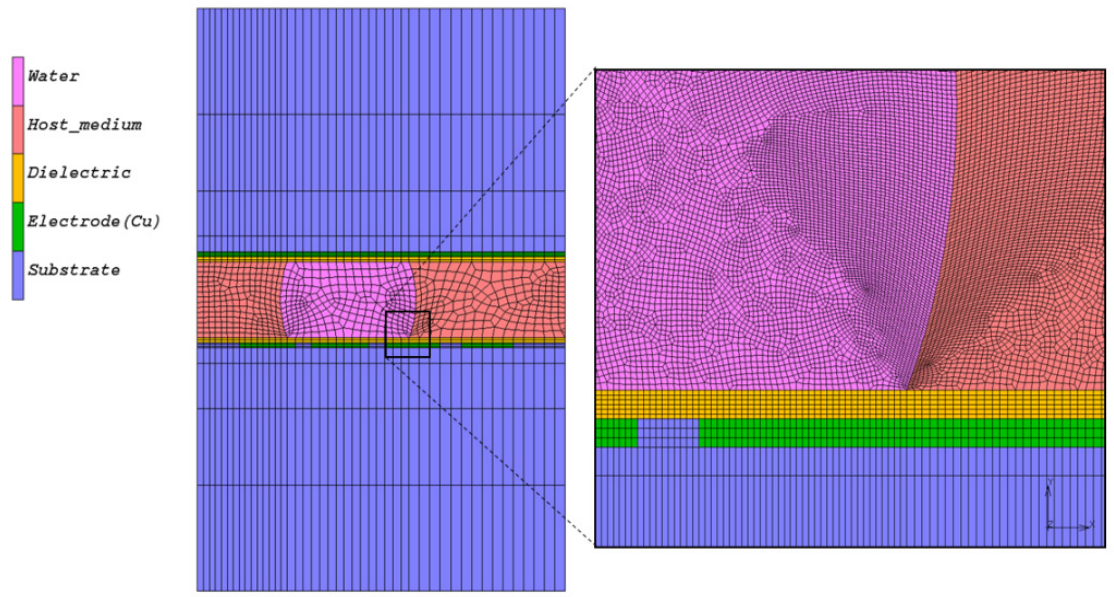
Figure 1. Example of a grid used in a 2D electrostatic simulation ( left ). Detail of the refined mesh around the three-phase line where high gradients in the electric field are expected ( right